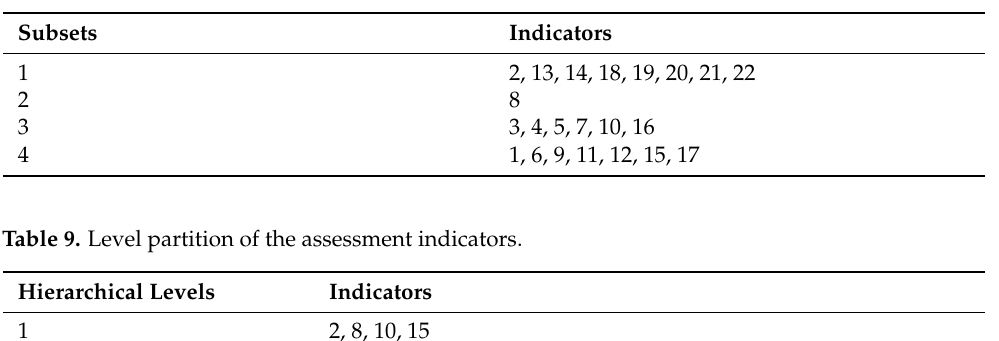
Table 8. Division of the assessment indicators.